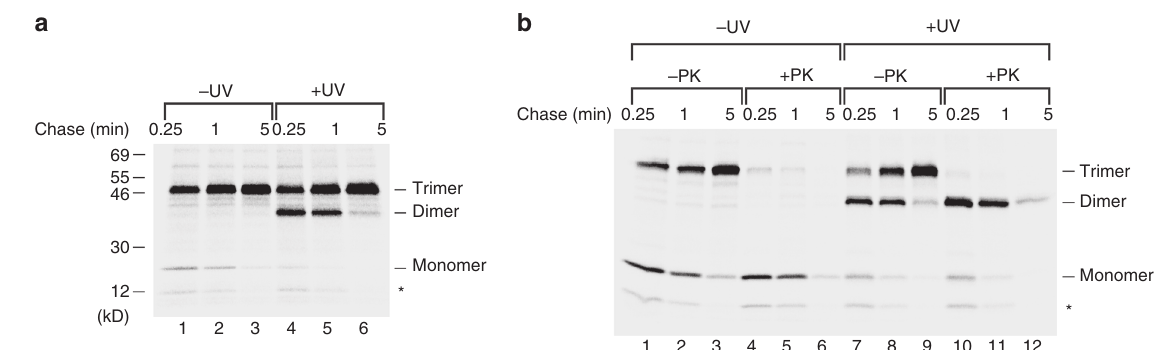
Fig. 2 UpaG Δ 2 monomers ef fi ciently form a crosslinking product. a AD202 transformed with pRS4 [P trc - HA-upaG Δ 2(Y1735am) ] and pDULE-Bpa were subjected to pulse-chase labeling. Half of the cells were UV irradiated, and immunoprecipitations were performed using an anti-HA antiserum. The truncated form of the protein that resulted from translation termination at the amber codon is denoted with an asterisk. b The experiment shown in ( a ) was repeated except that half of each sample was treated